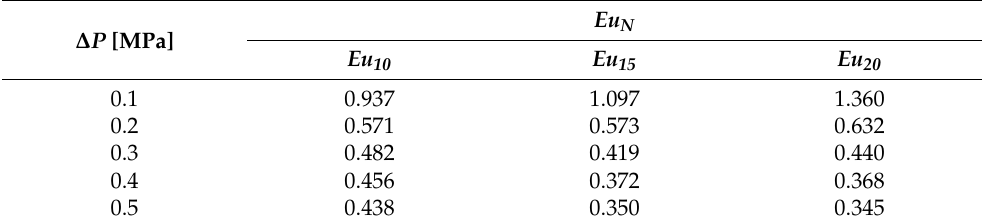
Figure 9. Eu*N and leakage rate Q with different rows. The left axis of Q represents the leakage rate, shown in solid lines, and the right axis of Eu*N represents the total pressure loss, shown in the dotted lines. Table 4. The Eu value of 10 rows, 15 rows, 20 rows bristles, where Eu N is the Euler number of N- row case; ∆ P is the differential pressure between Inlet and